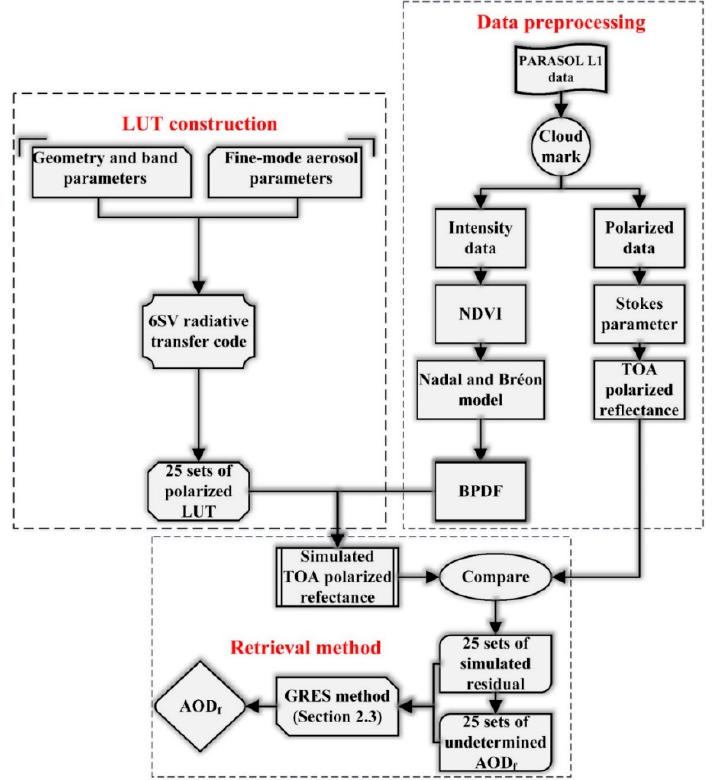
Figure 1. Flowchart of the AOD f retrieval in this study.